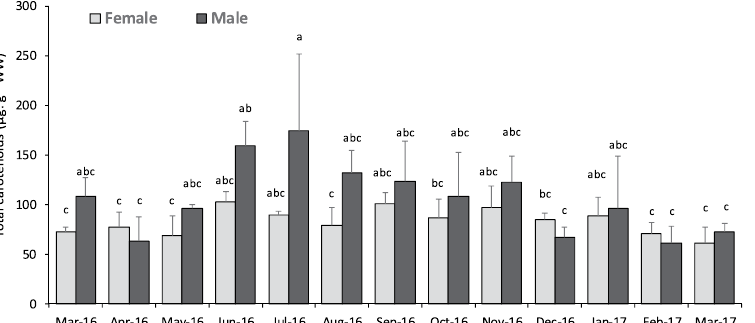
Figure 4. Total carotenoid content in gonads (ovary and testis) of P . lividus collected at Praia Norte (Portugal) over a 13-month period. Values are mean ± standard deviation; per month the 18 individuals were pooled by sex: N = 3 pools of female gonads and N = 3 pools of male gonads were established. Superscripts in lowercase letters indicate significant differences between sex X months ( abc ) (P <